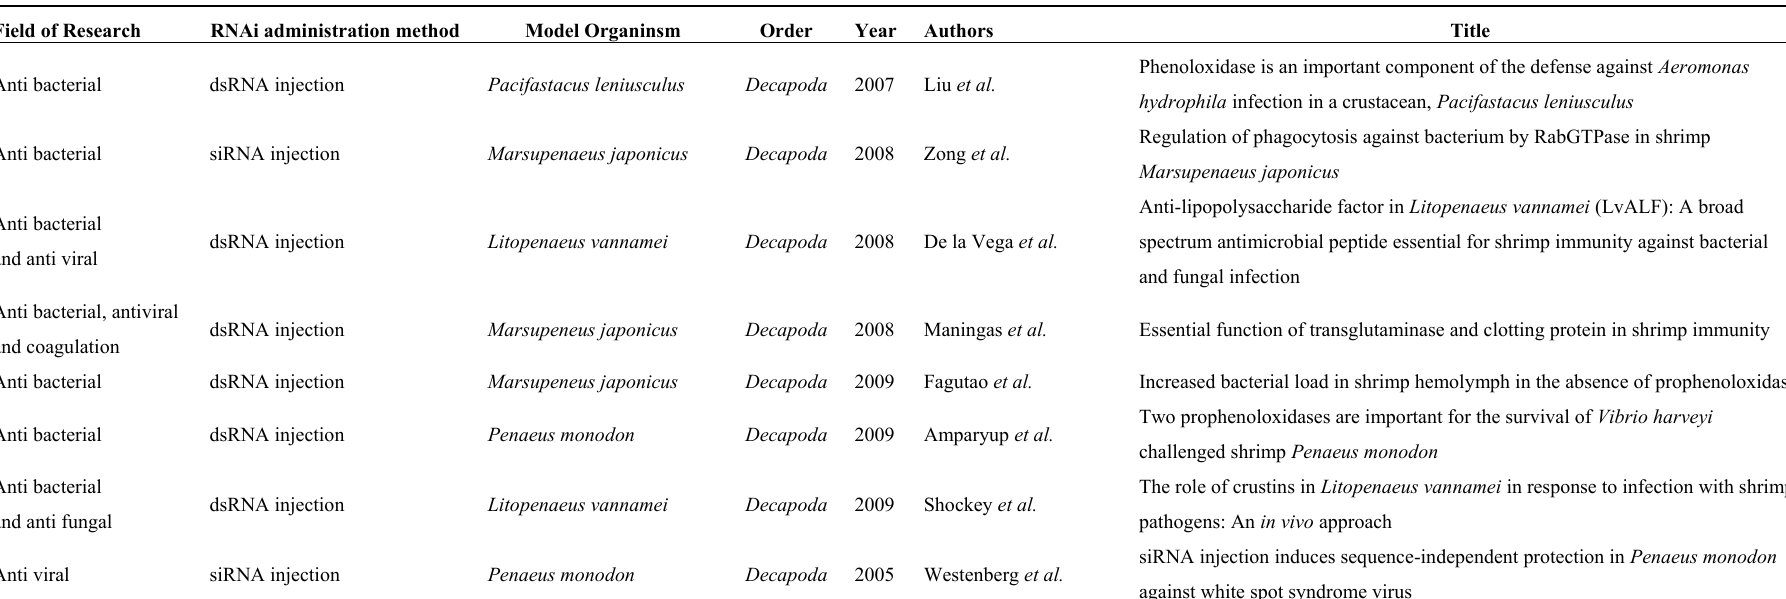
Table 3. Study of the crustacean innate immune system using